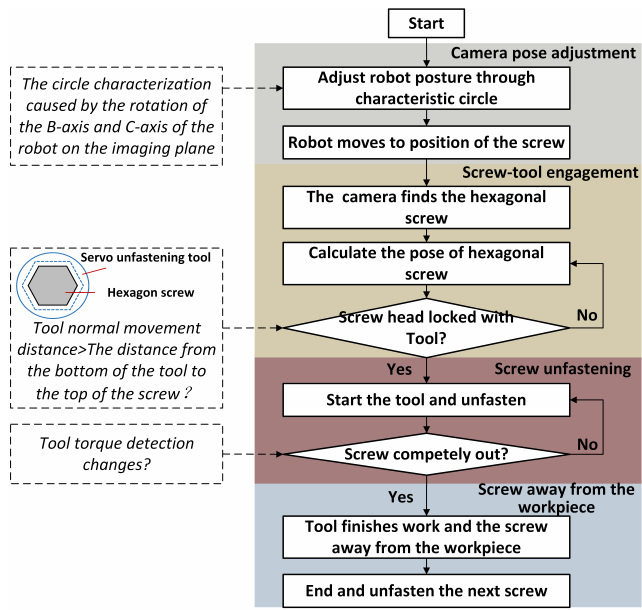
Figure 6. The flowchart of the screw unfastening